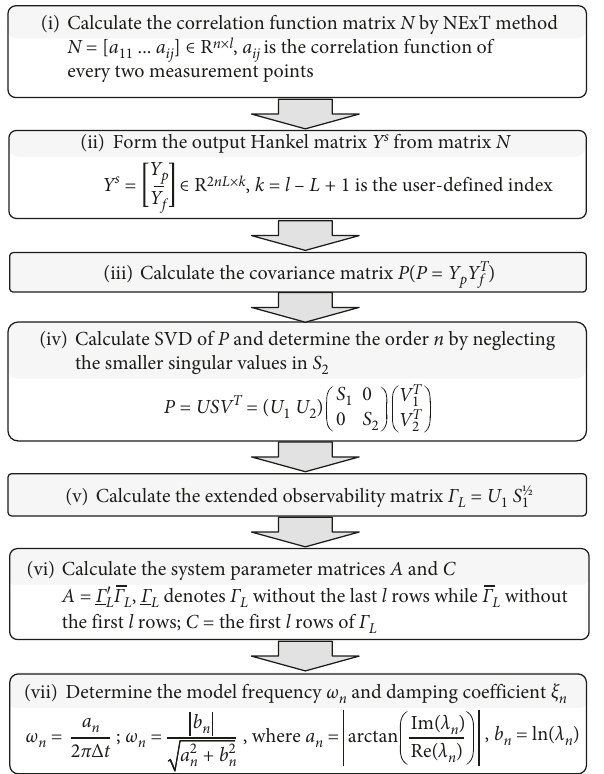
Figure 1: The flowchart of the NExT-SSI-COV